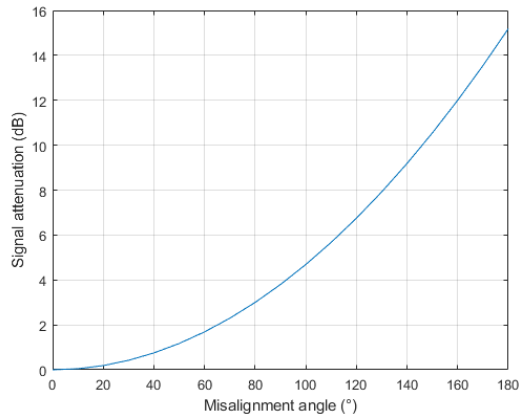
Figure 11. Signal attenuation for misalignment error of the satellite antenna.